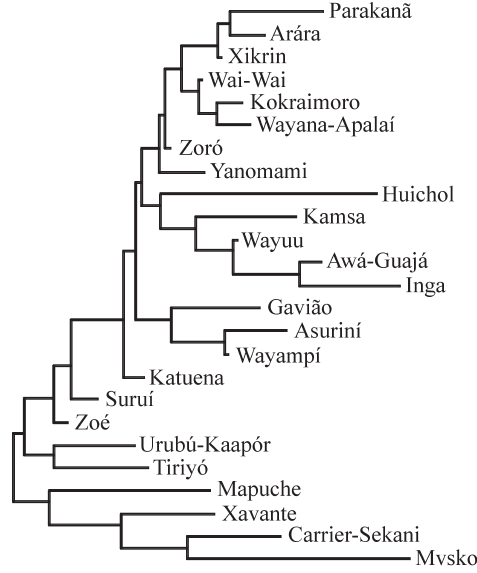
Figure 1 - Dendrogram constructed by the neighbor-joining method, showing the relationships between Amerindian tribes based on β -globin gene cluster haplotype